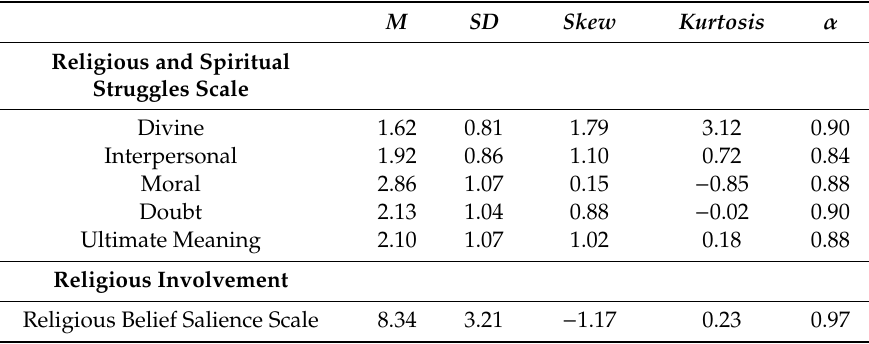
Table 3. Descriptive Statistics for Closed-Ended